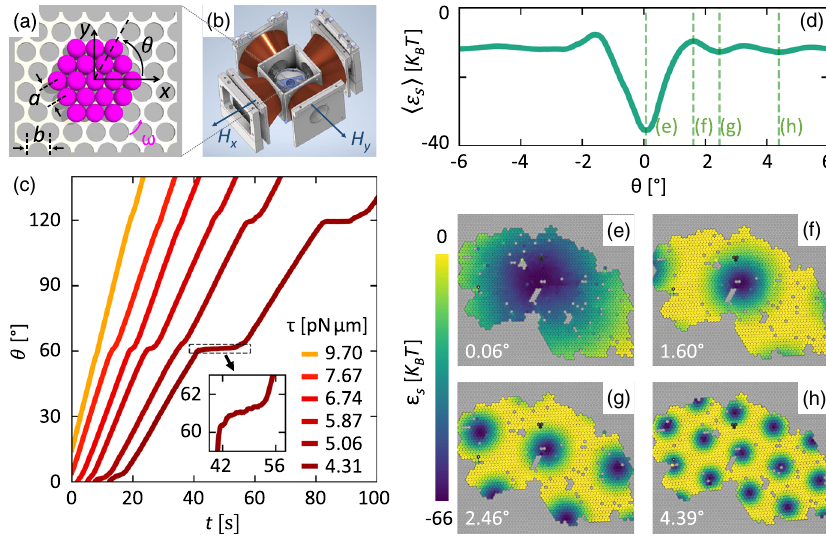
FIG. 1. Orientational cluster motion on periodic surfaces. (a),(b) Illustration of the experimental setup. Two perpendicular pairs of coils generate a rotating magnetic field in the sample plane with frequency ω . It applies a torque τ to the clusters leading to their rotation H with angular velocity ω ≪ ω on top of a topographically patterned surface with triangular symmetry. The conical shape of the coils H maximizes the magnetic strength and the area of the uniform field at the center. The angle θ denotes the lattice direction of the colloidal cluster, relative to the x axis (i.e., substrate lattice direction). (c) Temporal evolution θ ð t Þ for a cluster with N ¼ 133 when rotating on a surface with δ ¼ 1 . 1% under various applied torque τ . Inset: Magnified view of the plateau on the τ ¼ 4 . 31 pN μ m curve. (d) The interaction energy h ϵ as a function of θ for a cluster with N ¼ 1715 on a δ ¼ 1 . 1% surface. hi denotes the average over all particles in s i the cluster. The dashed lines indicate the snapshots in (e) – (h). (e) – (h) Snapshots of the cluster in (d) at angles θ ¼ 0 . 06 °, 1.60°, 2.46°, 4.39° under applied torque τ ¼ 6 . 68 pN μ m. Particles are color coded according to their interaction energy ϵ with the substrate (see s Appendix C for calculation of ϵ s